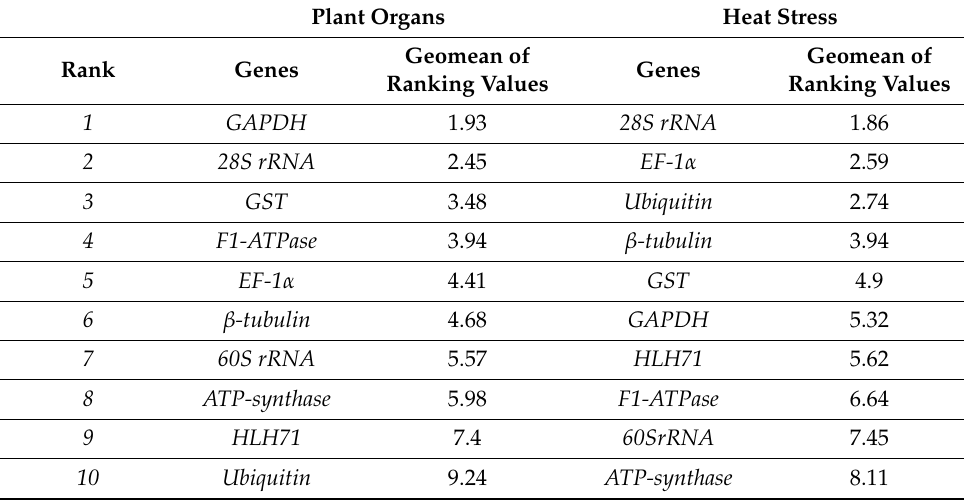
Table 4. Comprehensive ranking of candidate genes analyzed by